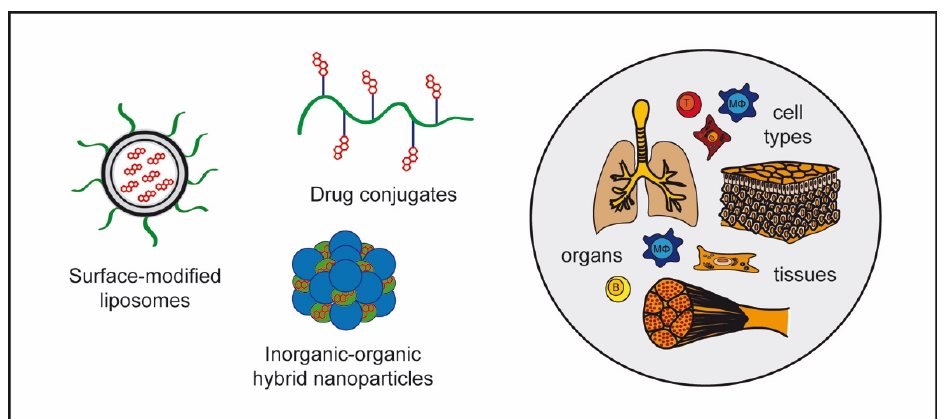
Figure 4. GC nanoformulations. Encapsulation of GCs in nanostructures of diverse chemical nature makes it possible to selectively target individual cell types, tissues, and organs, thus reducing systemic side effects of the drug. These novel nanoformulations include surface-modified liposomes, inorganic-organic hybrid nanoparticles, and different drug conjugates.